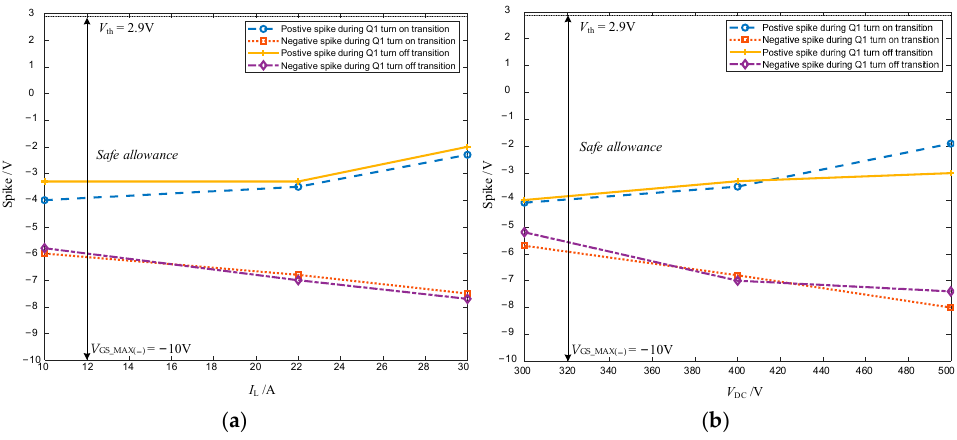
Figure 11. Spikes of spurious pulses at different working conditions, ( a ) I L and ( b ) V DC .